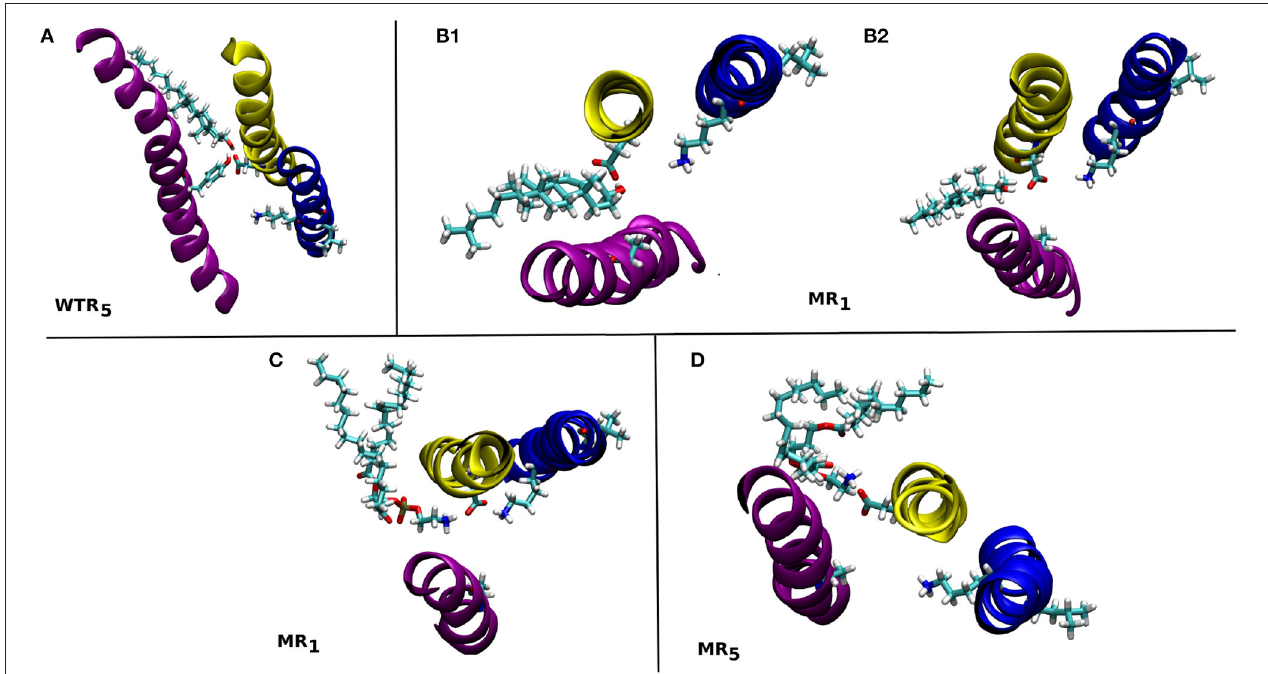
FIGURE 12 | Snapshots from the MD simulations showing some of the lipids that form hydrogen bonds with residues 441 and/or 238 in the WTR (A) and MR (B–D) . These are discussed in the text. M1: yellow, M2: blue, M4: